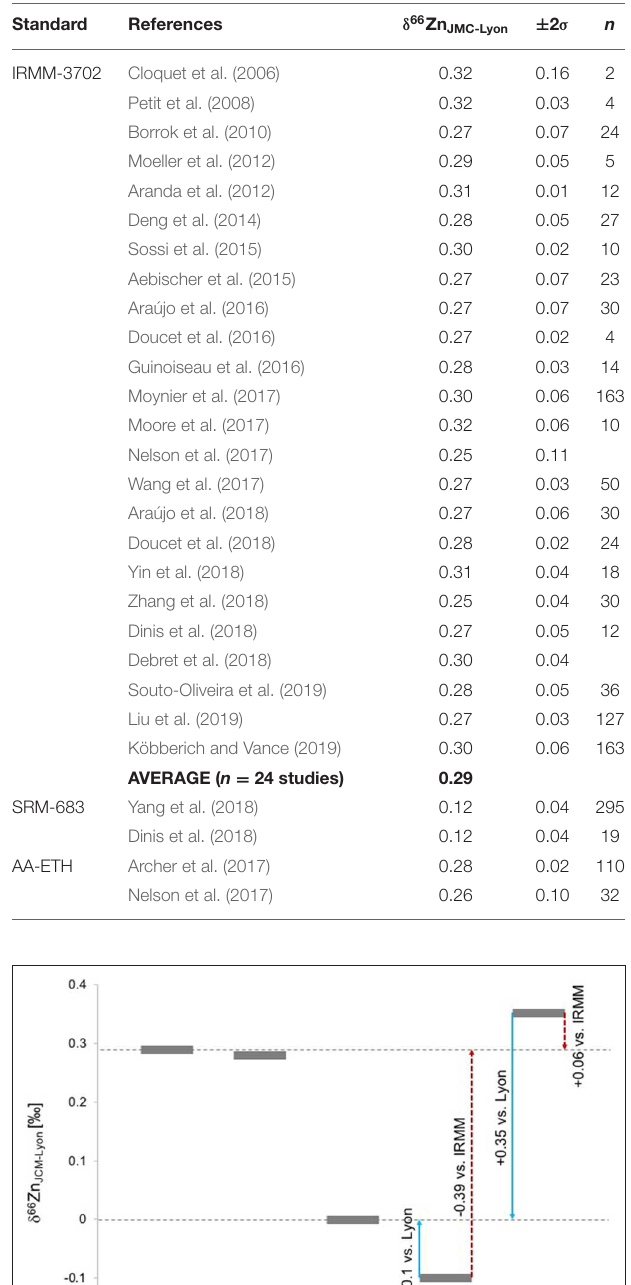
TABLE 2 | δ 66 Zn JMC − Lyon values of different international standard materials.